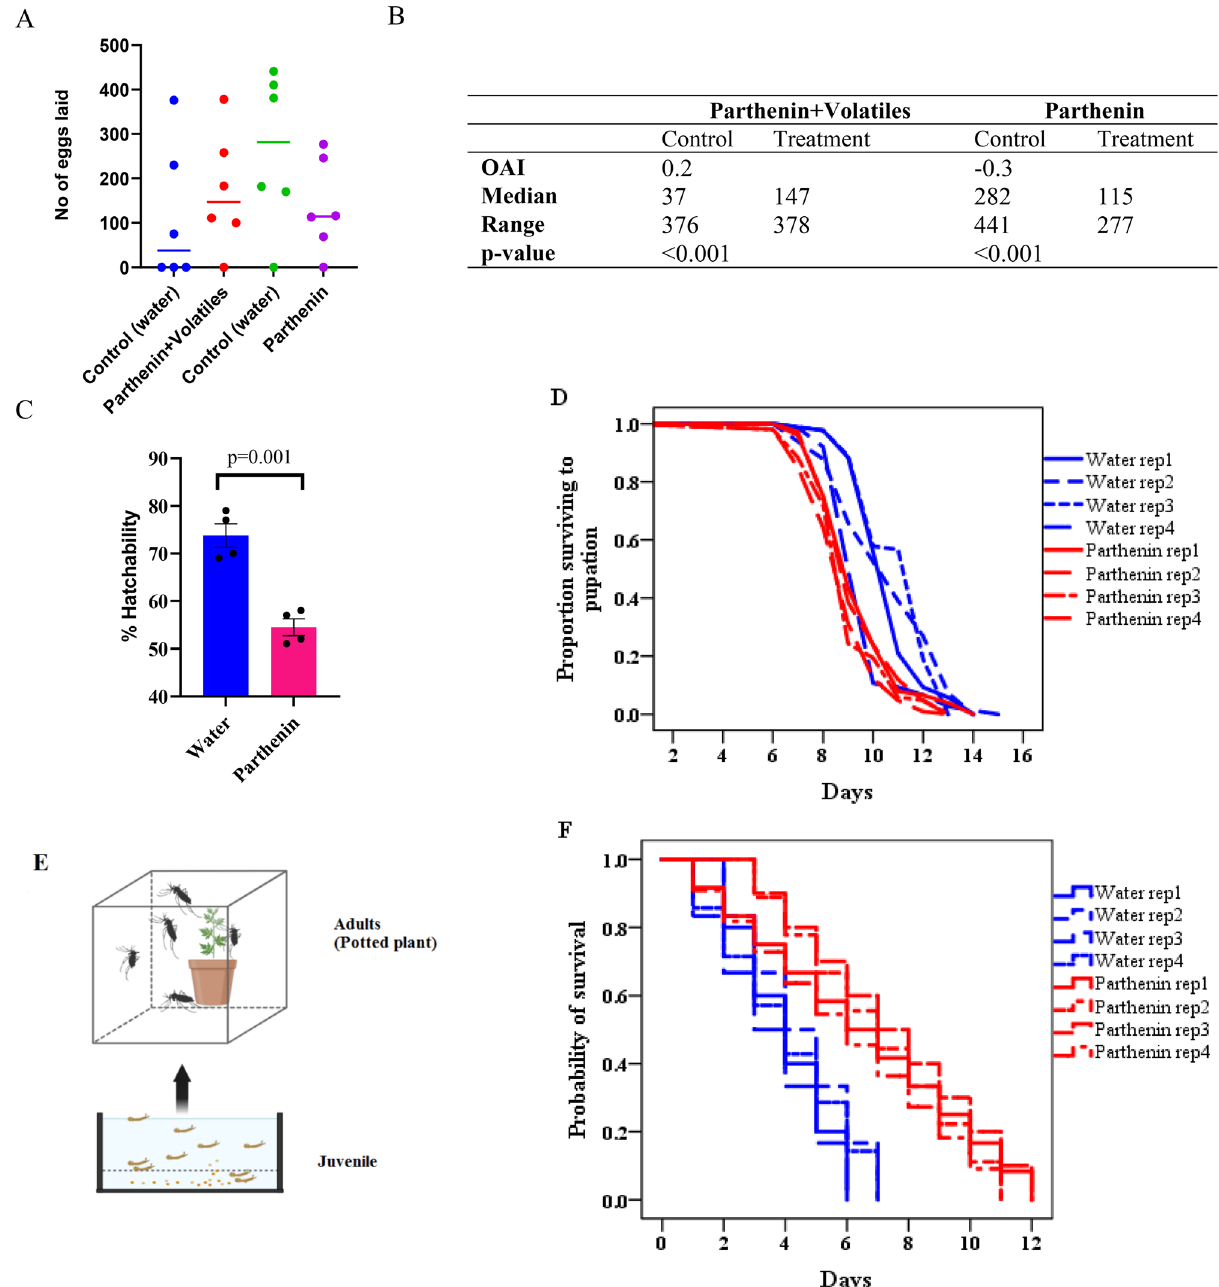
Figure 3. Effect of parthenin on An. gambiae oviposition activity and development. ( A ) Oviposition activity of parthenin treated water and distilled (control) water. ( B ) Table summarizing median number of eggs laid and the range. ( C ) Egg hatch rates was low in parthenin water compared to control water. ( D ) Time to pupation (days) for larvae exposed to parthenin relative to control water. ( E ) Pictorial illustration of the survival assays. ( F ) Effect of pre-exposure to parthenin on the survival of An. gambiae adult female mosquito. Exposed mosquitoes survived longer than the non-exposed when fed on intact